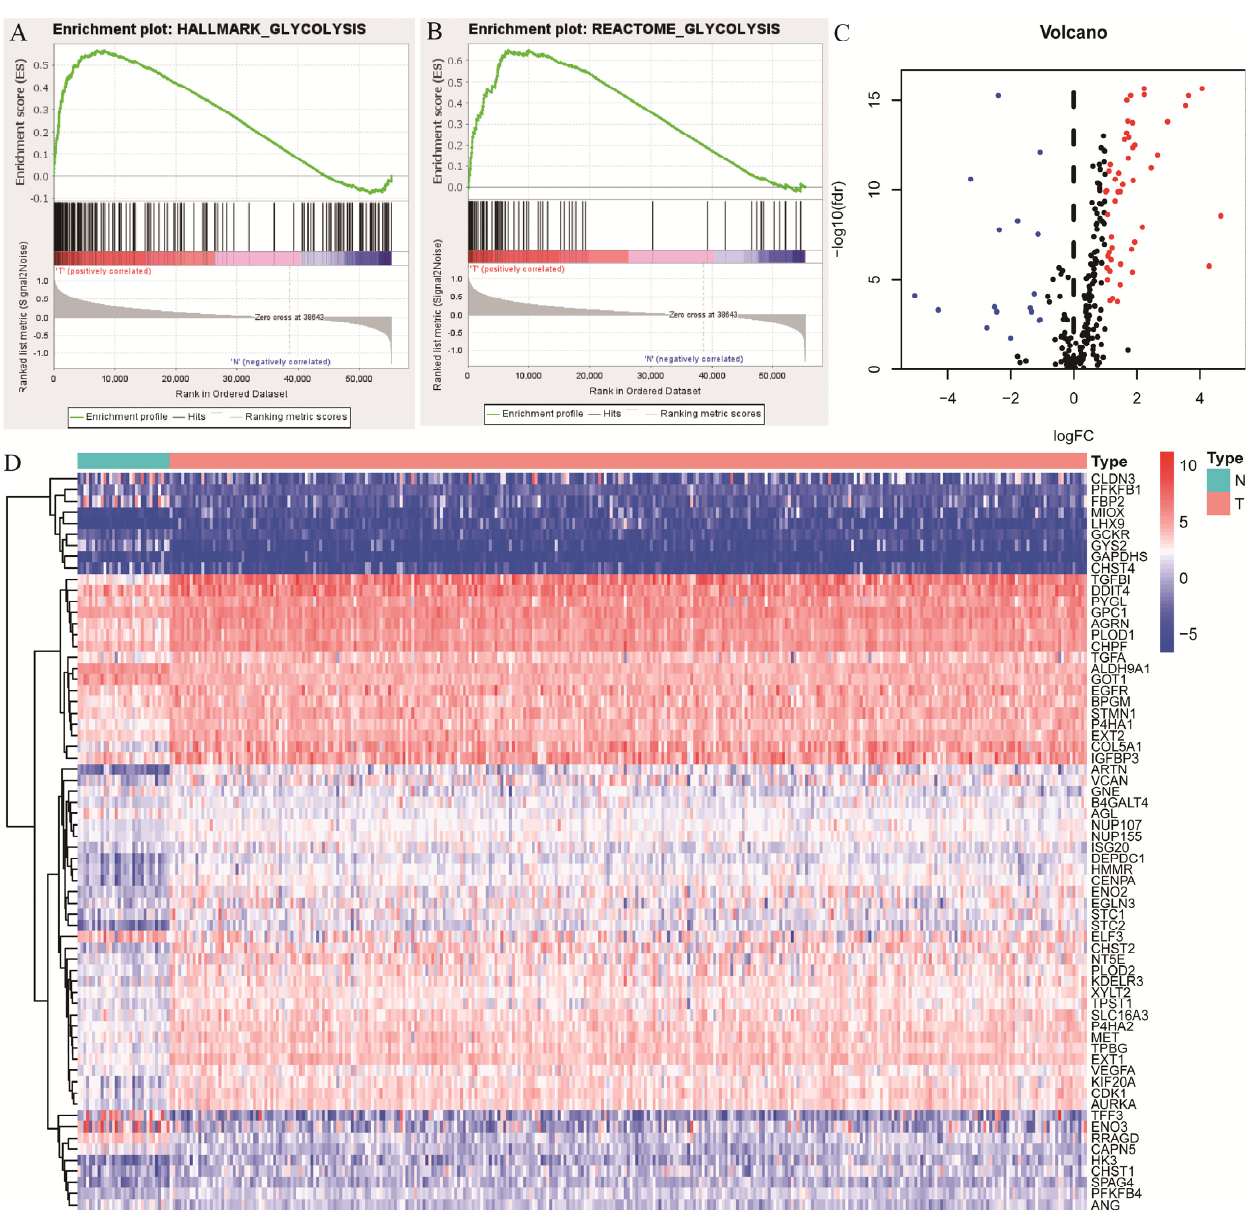
Figure 1. Gene set enrichment analysis (GSEA) screening of glycolysis-related gene sets. ( A , B ); Hallmark − glycolysis and reactome − glycolysis were significantly activated in OSCC. Higher hallmark − glycolysis and reactome − glycolysis activation were positively related to tumor samples. ( C , D ), The heatmap and volcano plot of differentially expressed core genes (DECGs) in these 2 gene sets. Blue and red stand for downregulation and upregulation, respectively. Table 2. The downregulated glycolysis-related genes in OSCC.